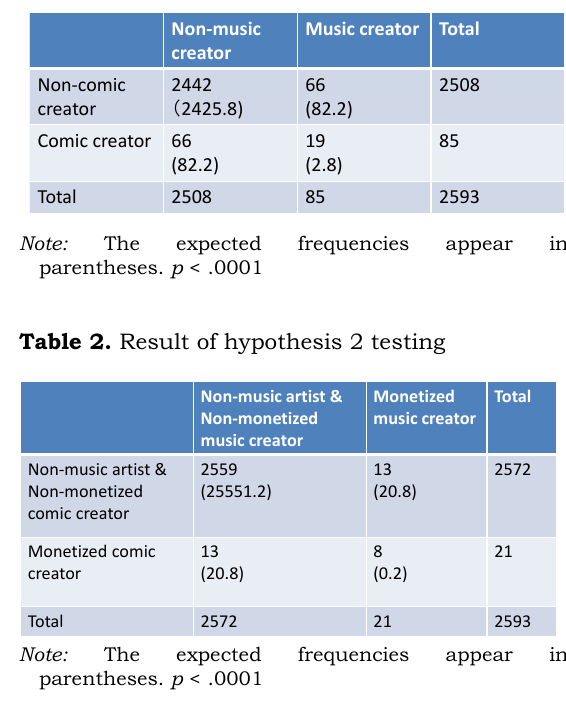
Table 1. Result of hypothesis 1 testing